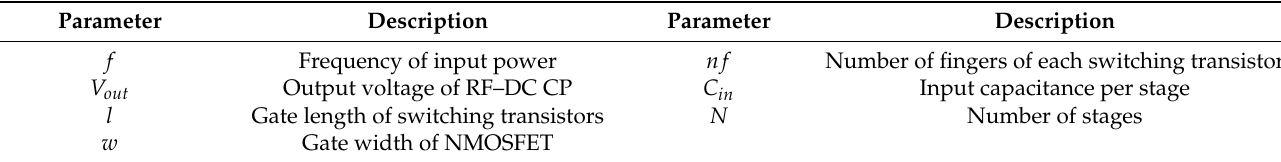
Table 1. Description of